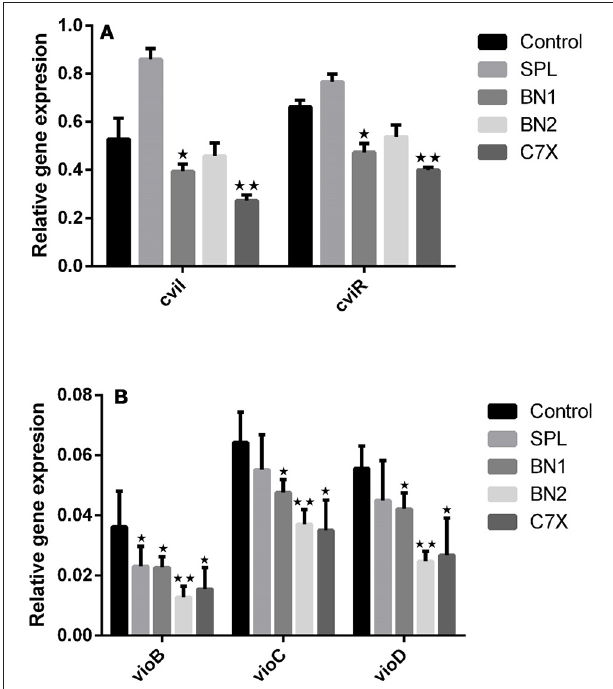
FIGURE 6 | The influence of QSIs on the genes which are under the control of CviI/CviR mediated quorum sensing. (A) The cviI and cviR genes were significantly suppressed by BN1 and C7X. (B) The genes involved in violacein biosynthesis were significantly suppressed by BN2. * P < 0.05 and ** P <